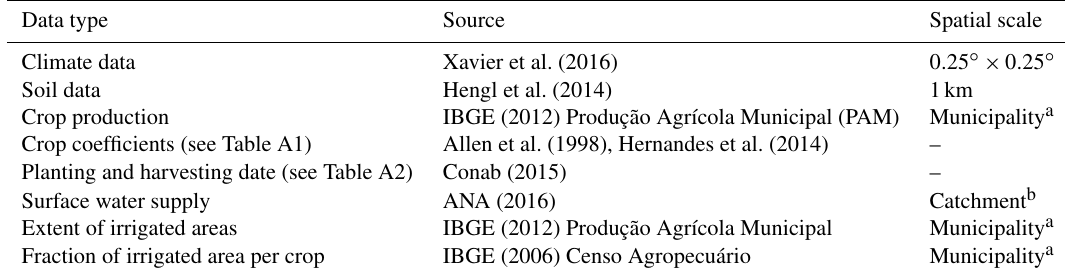
Table 1. Data used in this study and respective